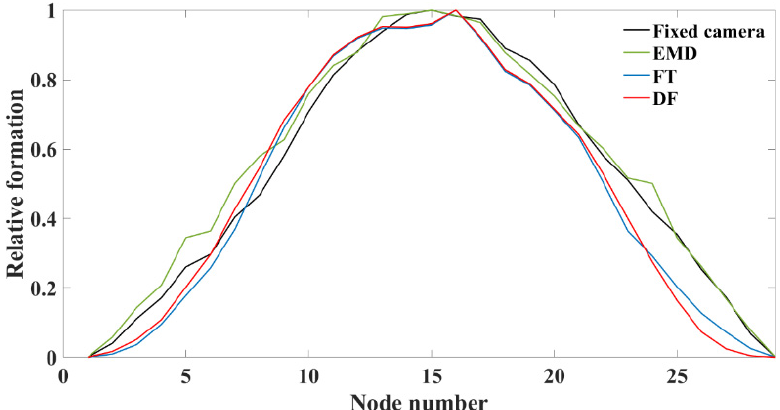
Figure 17. The mode shape identified by four methods.